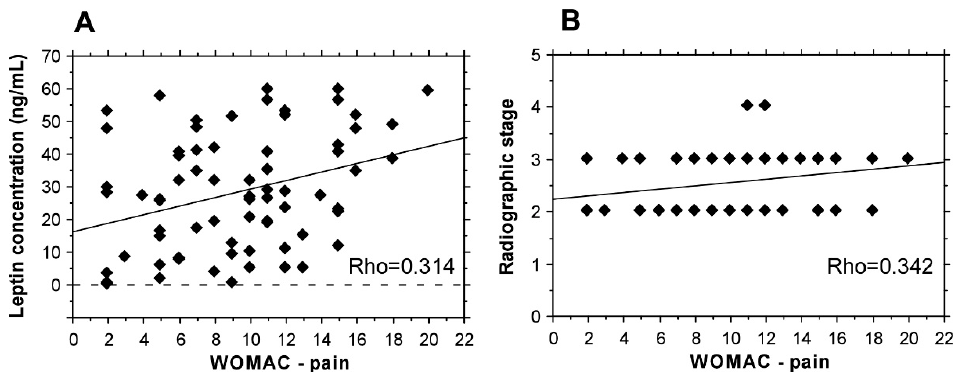
Figure 2. WOMAC-pain score correlations. ( A ) Association with leptin serum concentrations. ( B ) Correlation between WOMAC-pain score and radiographic stage.